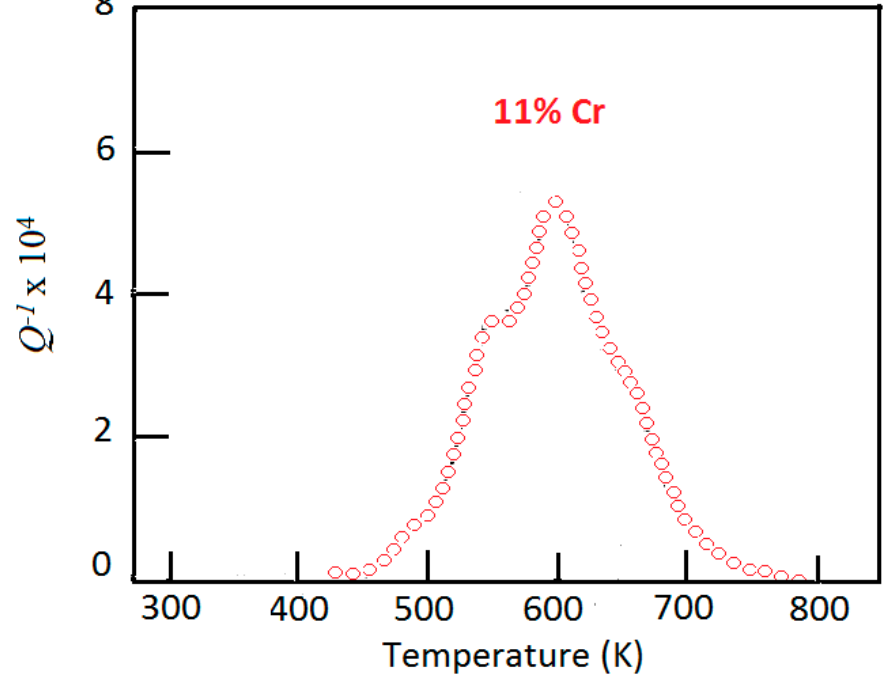
Figure 3. Q − 1 curve for an alloy with the same Cr and C content of the examined steel, calculated on the basis of Equation (3), according to the assumptions of Tomilin’s model. These data were already published in ref. [27], but the present curve obtained through VRA 1604 is more precise in particular in the initial part.